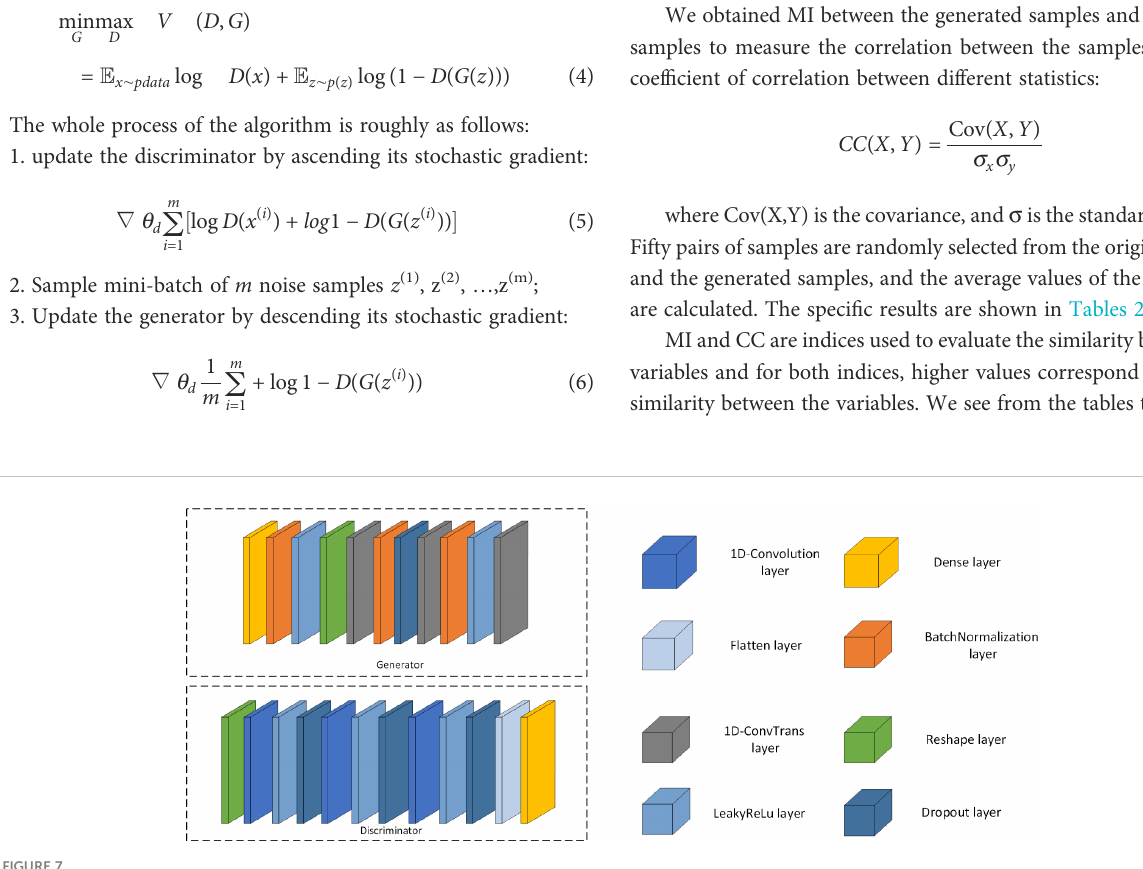
FIGURE 7 One-dimensional DCGAN